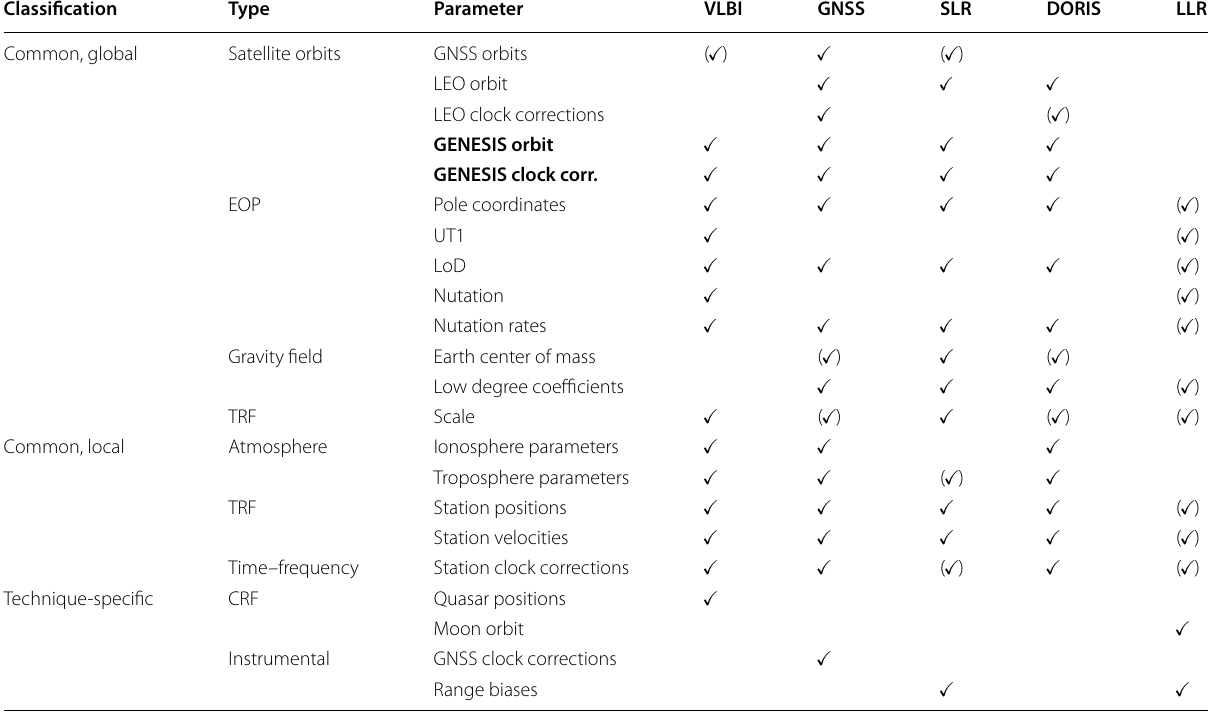
Co-location in space with GENESIS is marked in bold (adapted from Männel 2016)